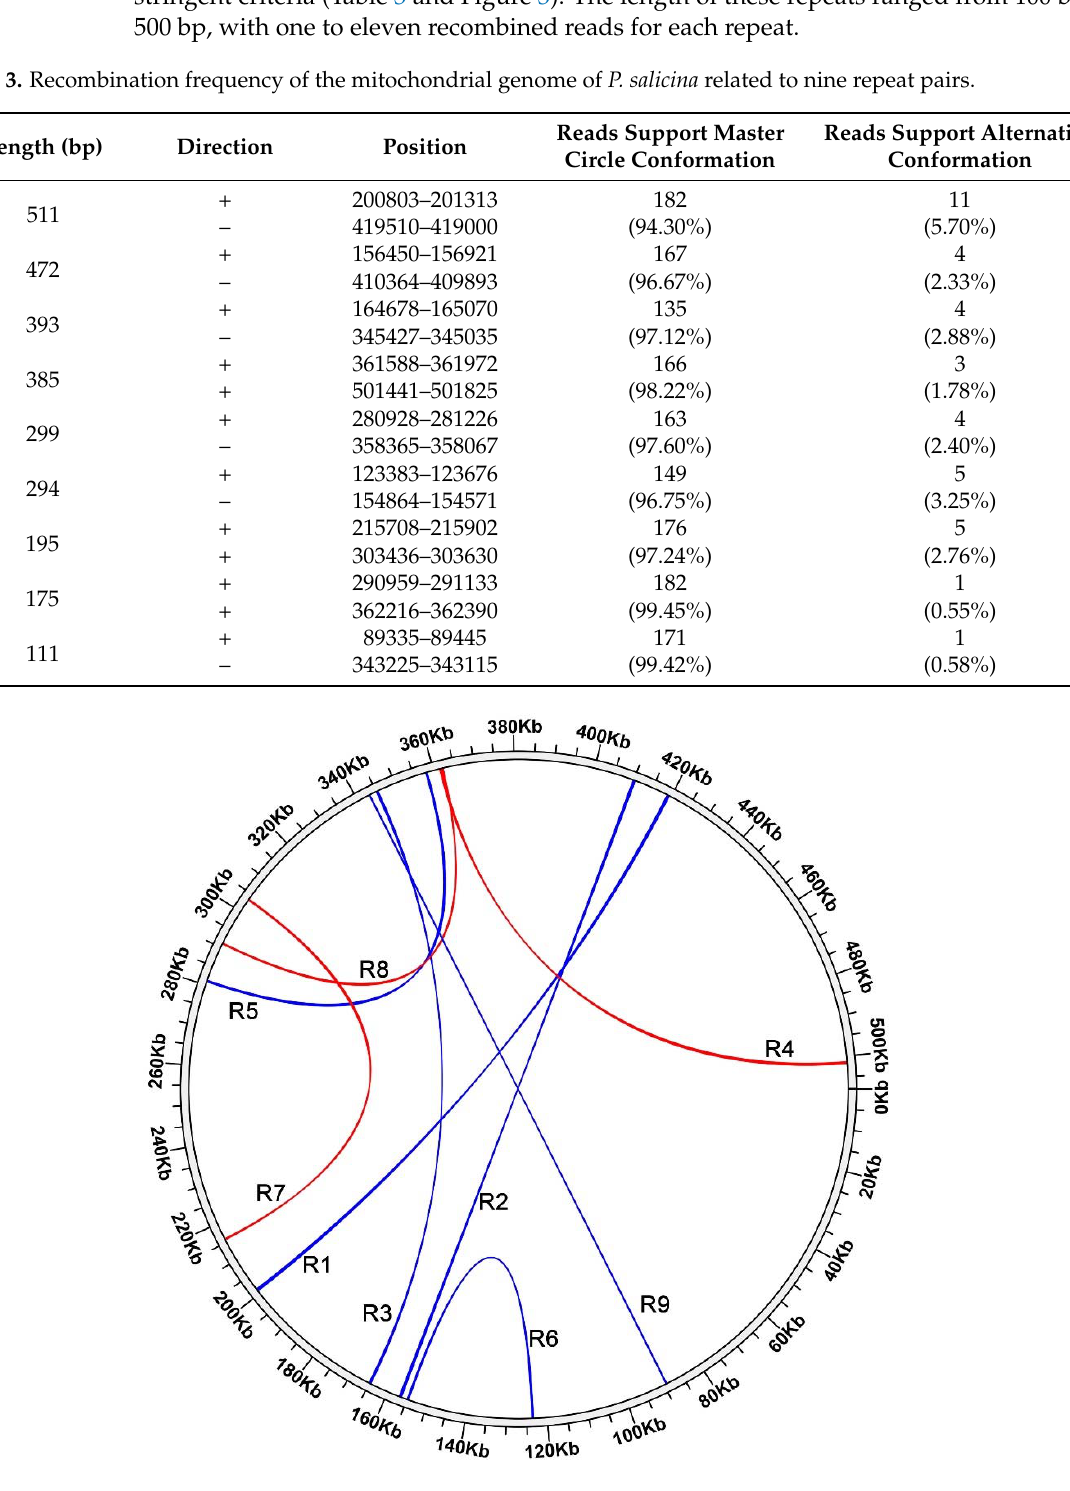
Table 3. Recombination frequency of the mitochondrial genome of P. salicina related to nine repeat pairs.